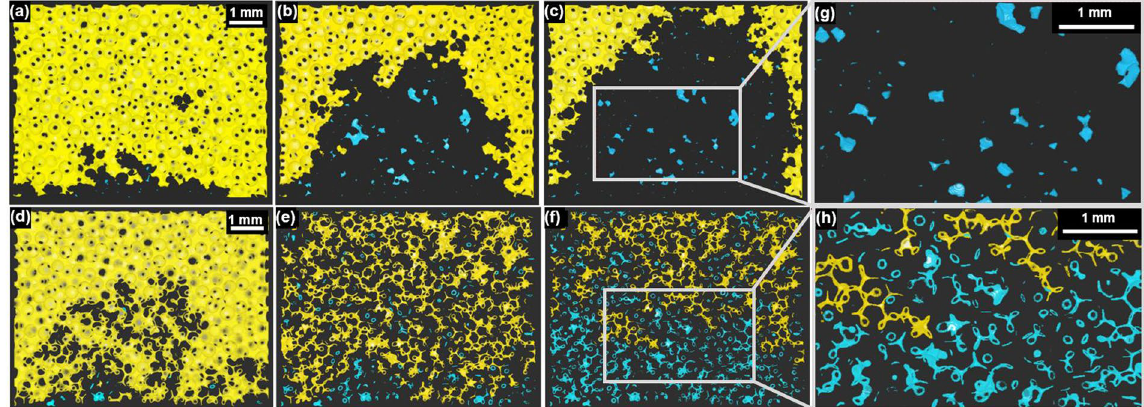
Figure 5. Percolated and disconnected oil morphologies during water injection. Time series of vertical cross- sections of one bead layer thickness. The percolated oil is shown in yellow and the disconnected oil ganglia are shown in blue. Beads and the defending phase are rendered transparent. ( a ), ( b ) and ( c ) represent time series of basalt beads with θ ≈ 75° after 0.1, 0.4 and 0.7 injected pore volumes (PV). ( d ), ( e ) and ( f ) represent time series of glass beads with θ ≈ 125° after 0.3, 2.9 and 10.4 injected PV. Zoomed section for basalt (g) and glass beads (h) after 0.7 and 10.4 injected PV, respectively.